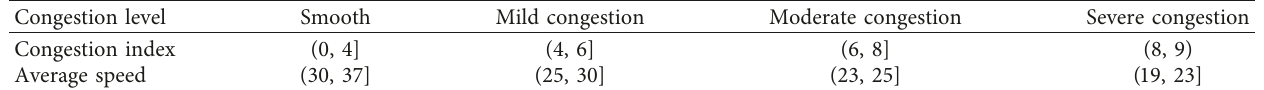
Table 2: Road congestion rating